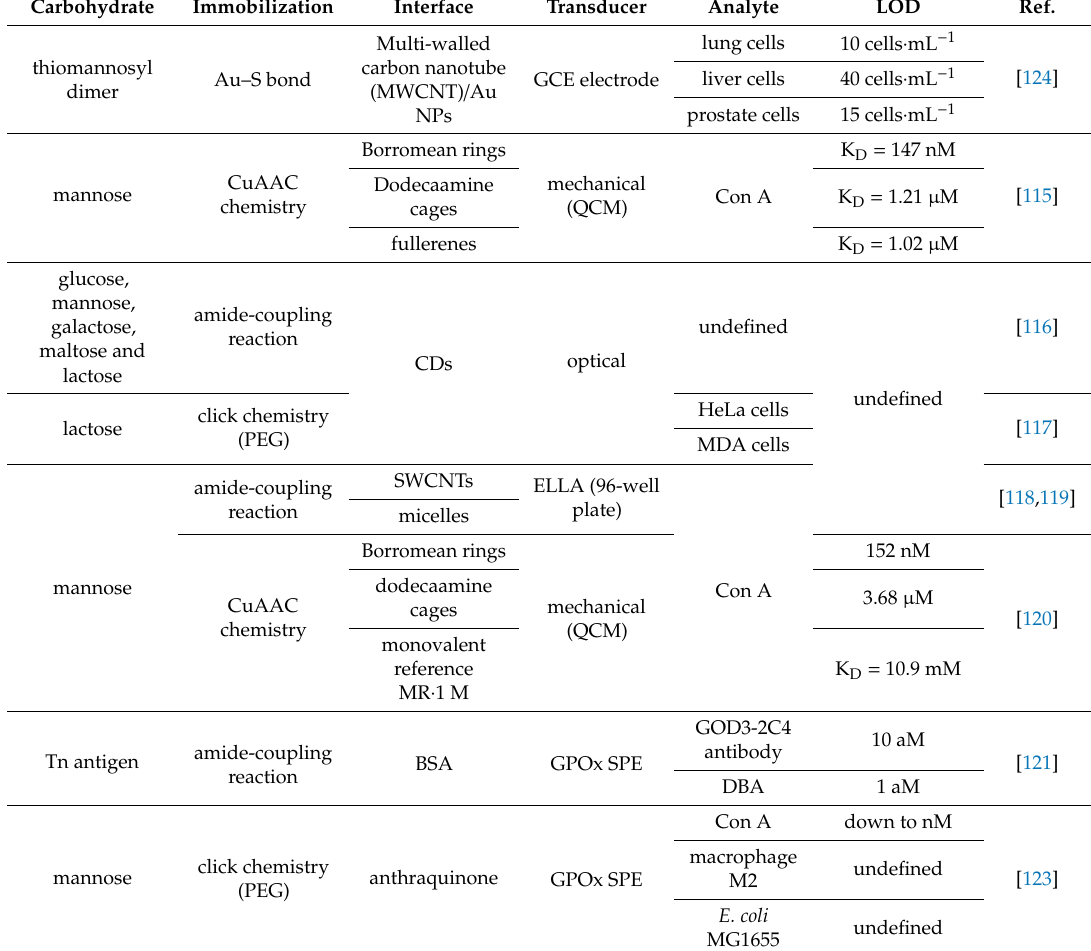
Table 4. Carbon nanomaterial-based glycan biosensors and their characteristics.